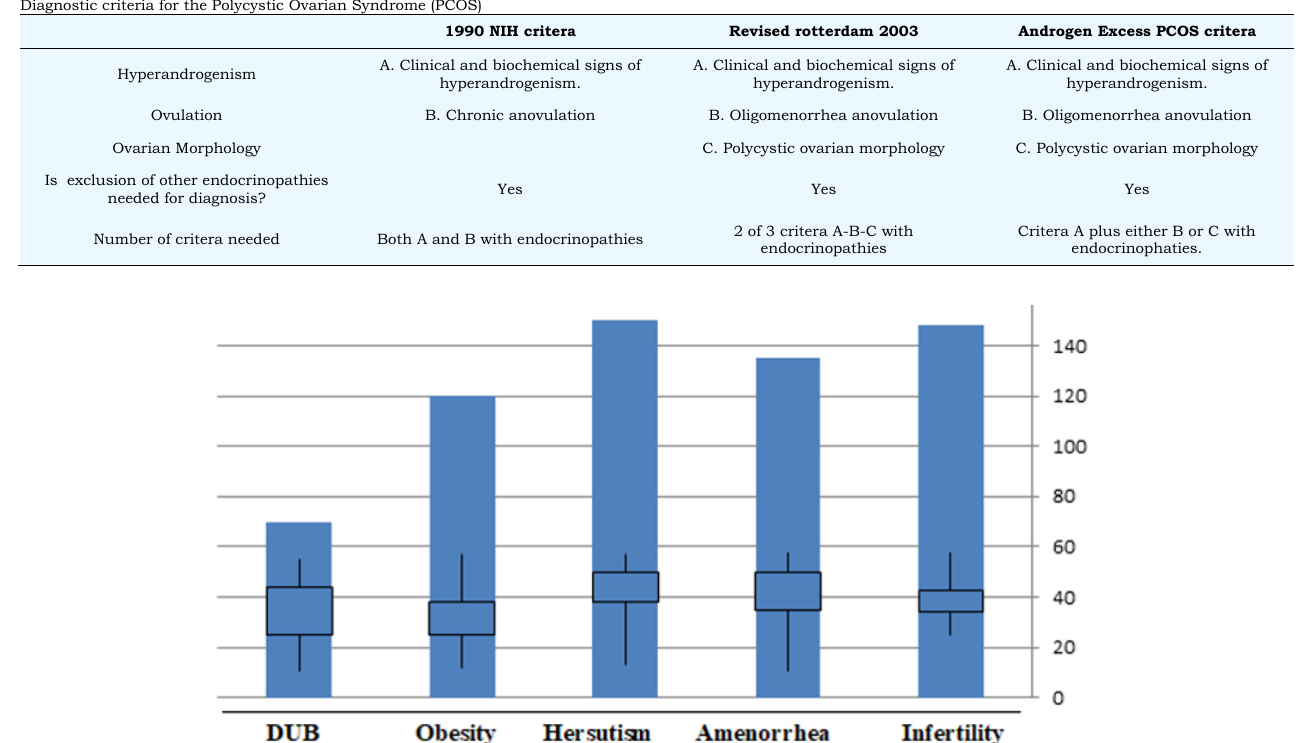
Fig. 5. The clinical symptoms for